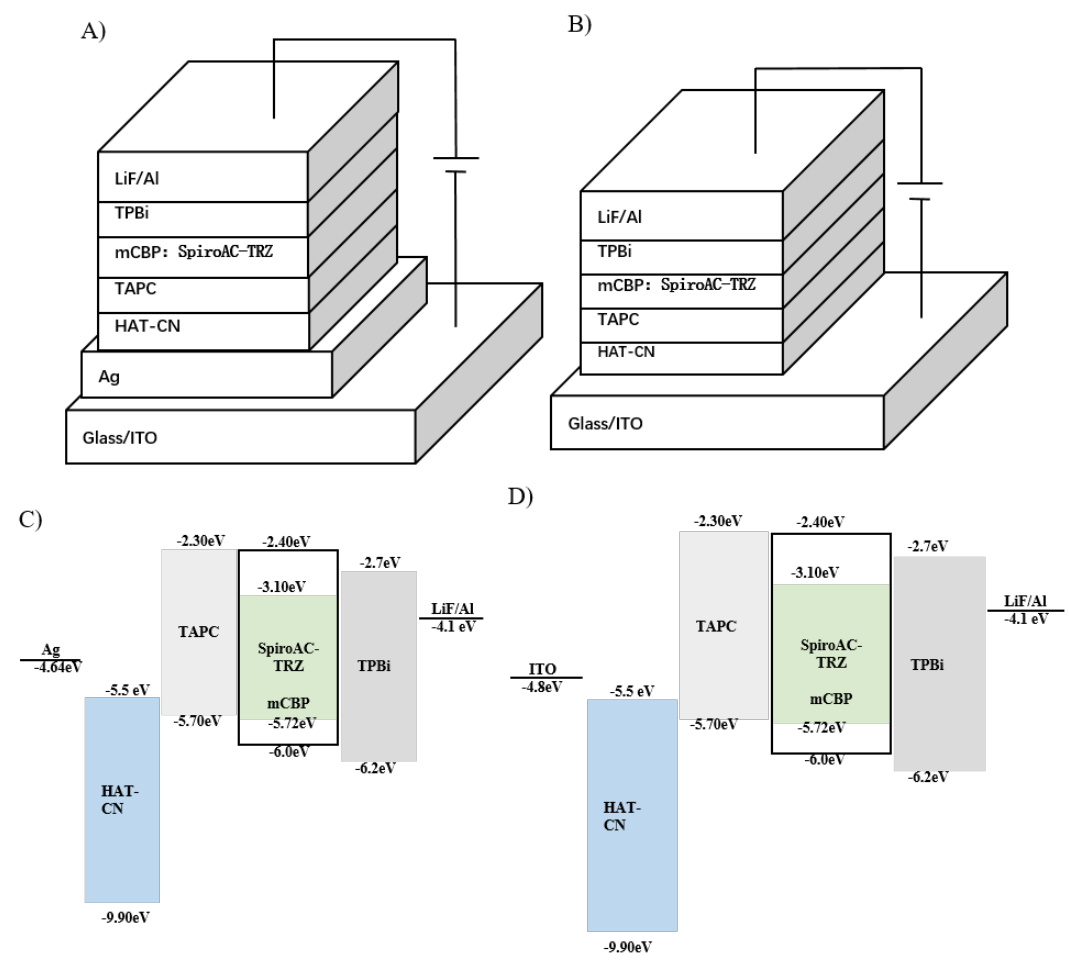
Figure 4. ( A ) Micro-cavity OLEDs device structure, ( B ) ITO-based OLEDs device structure, ( C ) Energy level of micro-cavity OLEDs, ( D ) Energy level of ITO-based OLEDs.